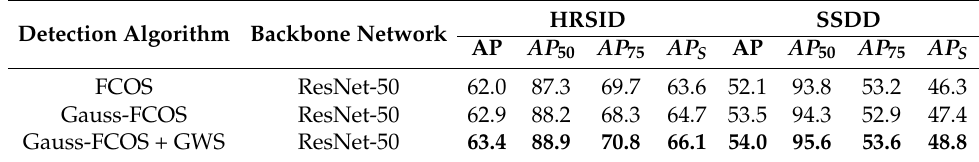
Table 8. Experimental results of the Gaussian function-based detection head on HRSID and SSDD. Detection Algorithm Backbone